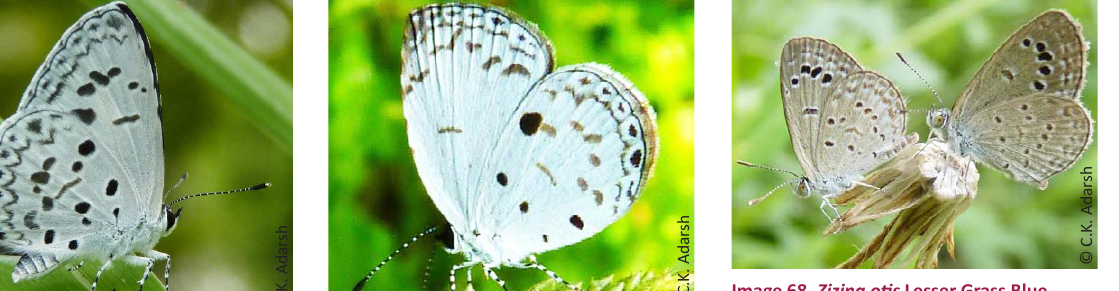
Image 68. Zizina otis Lesser Grass Blue